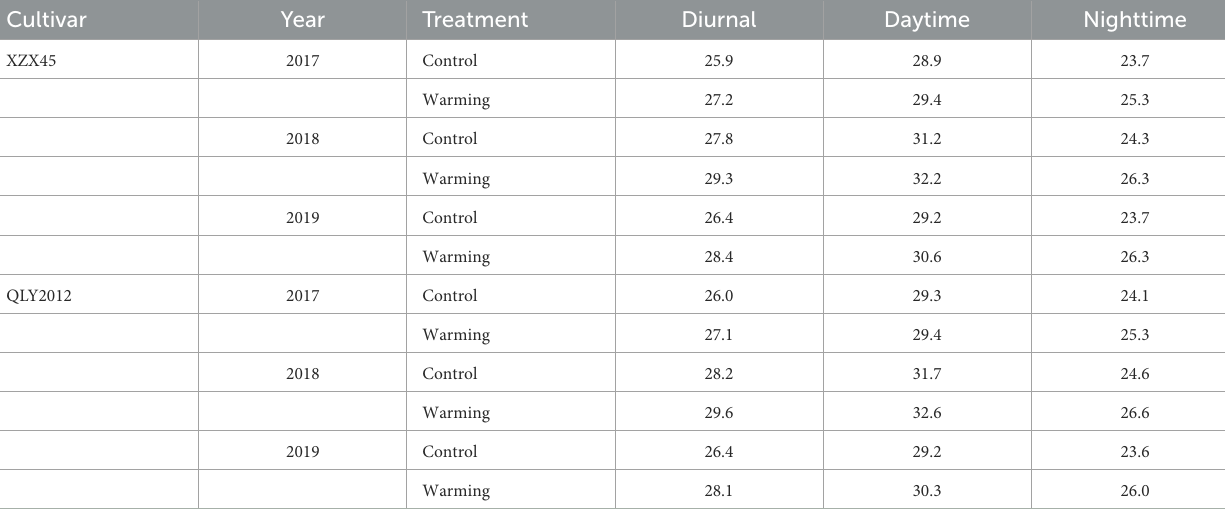
TABLE 1 Mean diurnal, daytime, and nighttime temperature ( ◦ C) in rice canopy during the grain-filling period (from heading to maturity). Cultivar